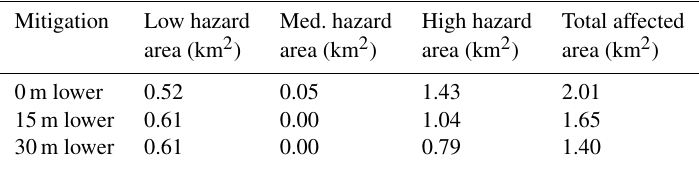
Table 7. Areas of each hazard level corresponding to the current lake level and two lake mitigation